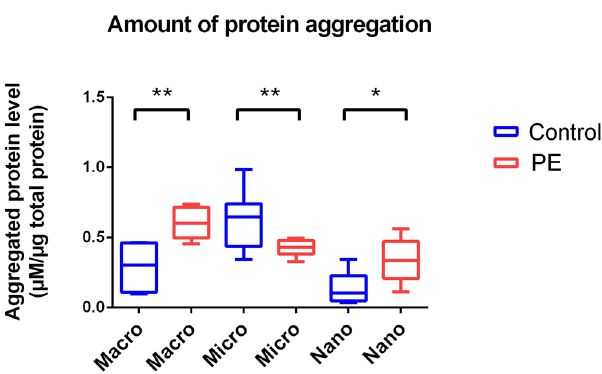
Figure 3. Levels of total aggregated protein in placental extracellular vesicles determined by ProteoStat Assay. The levels of total aggregated protein in macro-, micro- and nano- vesicles extruded from control and preeclamptic placentae were measured by a fluorometric ProteoStat ® assay. Having normalised to the amount of protein loaded, unpaired t-tests were performed to investigate statistical differences between the levels of aggregated protein present in each fraction of extracellular vesicles from control and preeclamptic placentae ( ** p < 0.001, * p < 0.05). Data is plotted as box-whisker plots showing the median, interquartile range (box) and maximum/minimum